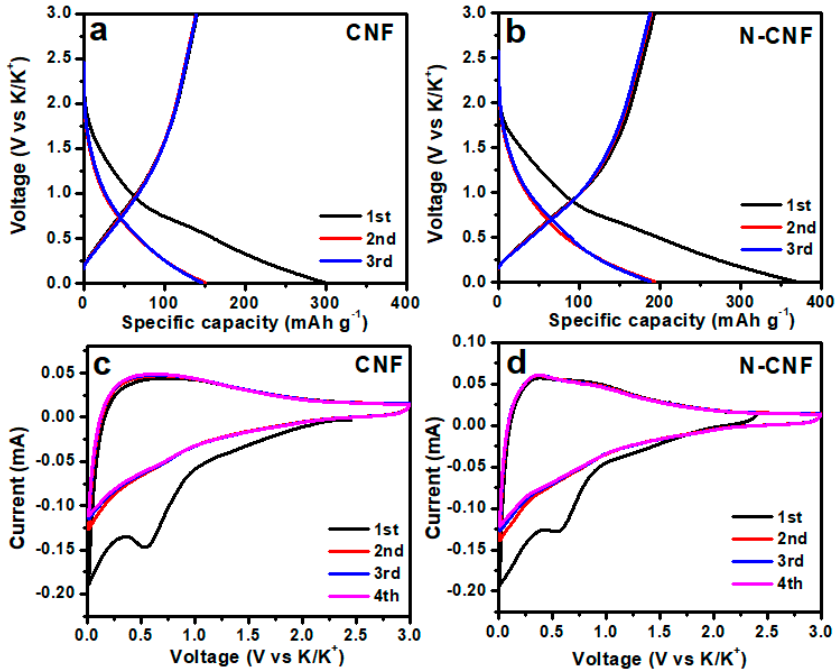
Figure 3. Initial GCD curves of ( a ) CNF and ( b ) N-CNF; initial CV curves of ( c ) CNF and ( d ) N-.